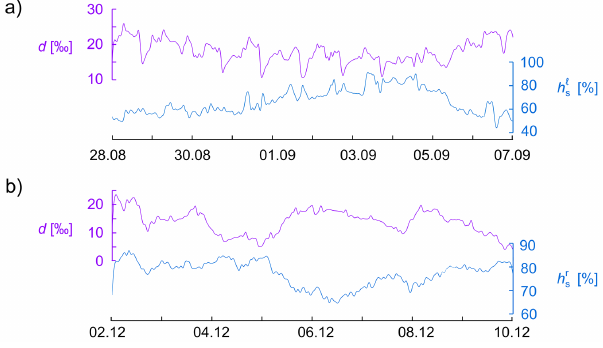
Fig. 6. Close-up of the d time series of Fig. 5a measured at Rietholzbach in violet and h ‘ s (a) respectively h r s (b) in blue for (a) summer (28.08.2011 to 07.09.2011) and (b) late autumn (02.12.2011 to